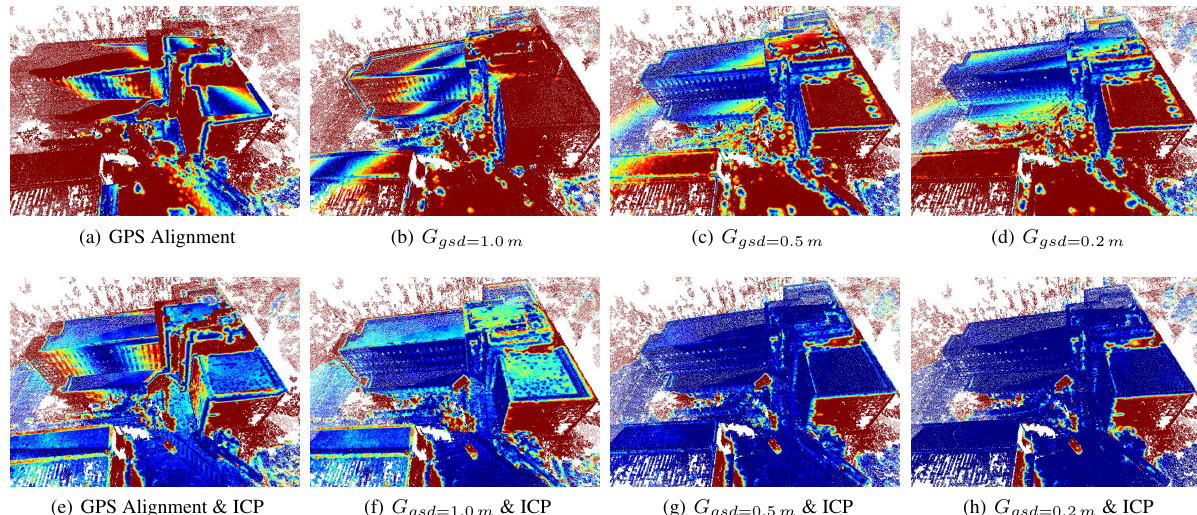
Figure 3: Alignment accuracy. Red points have a Hausdorff distance larger than 10cm. Blue points are closer than 1cm to the second model. (a)-(d) Accuracy after alignment using different ground sampling distances for G gsd without ICP. (e)-(h) Remaining error after solving Equation 3 with subsequent ICP. Note that points present in only one part of the reconstruction by definition have a Hausdorff distance of more than 10cm and are thus colored in red. Best viewed in